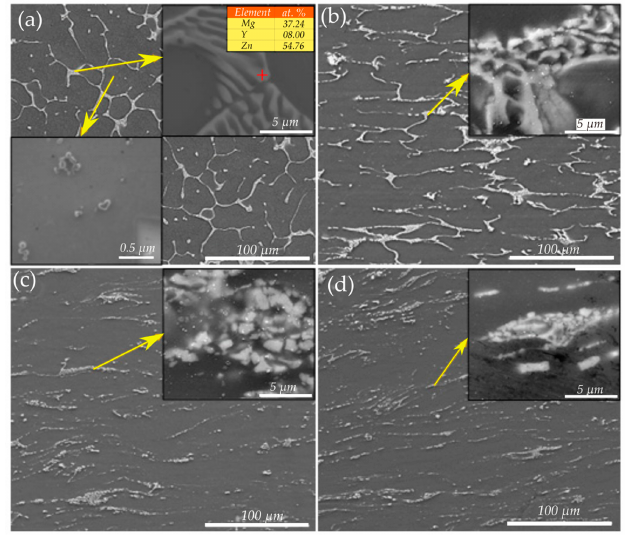
Figure 17. SEM micrographs of the ( a ) as-cast, ( b ) ESRed, ( c ) HRDSRed (with an SR of 2) and ( d ) HRDSRed (with an SR of 3) Mg–9.25Zn–1.66Y alloy. The insets in ( a – d ) show the eutectic I -phase pockets before and after ESR or HRDSR [84]. Reproduced with permission from Kwak et al., Scr. Mater. ; published by Elsevier, 2015. Superplasticity of the HRDSRed Mg alloys with finely and uniformly dispersed Mg 17 Al 12 , MgZn 2 , (Al,Mg) 2 Ca and I -phase particles [85–89] is compared with that of the Mg alloys subjected to SPD by ECAP [90,91]. This is shown in Figure 18. The comparison was made at a given strain rate of 10 − 3 s − 1 . The following results are observed from the plot. Firstly, the HRDSR processed Mg alloys show superplasticity almost equivalent to that exhibited by Mg alloys processed by ECAP. Secondly, depending on the chemical composition (i.e., the type and amount of secondary phase), the degree of superplasticity achieved from the Mg alloys processed by HRDSR is different. Some HRDSRed Mg alloys exhibit good superplasticity in the temperature range of 473–523 K, while some HRDSRed Mg alloys do in the temperature range of 523–573 K. It is usually expected that increasing temperature and decreasing strain rate increases superplasticity, but poor superplasticity is observed above 573 K. This is because ultra-fine grains became unstable above 523 K [87]. Simultaneous achievement of low-temperature superplasticity below 0.5 T m ( T m : melting temperature) and high-strain-rate superplasticity (HSRS: superplasticity at strain rates above 10 − 2 ·s − 1 ) above 0.5 T m from the identically processed material is advantageous for industrial application of superplastic forming technique, but achievement of HSRS above 0.5 T m is difficult due to the instability of ultrafine grains at high temperatures. Recently, Lee and Kim [92] showed that by controlling the speed ratio in HRDSR, one can develop a microstructure that is stable at high temperatures above 0.5 T m in Mg–Y–Zn–Zr alloys by controlling the particle size and distribution through using different SR. The properly processed alloy exhibited excellent HSRS at 673 K (~700 % at 10 − 2 s − 1 ).